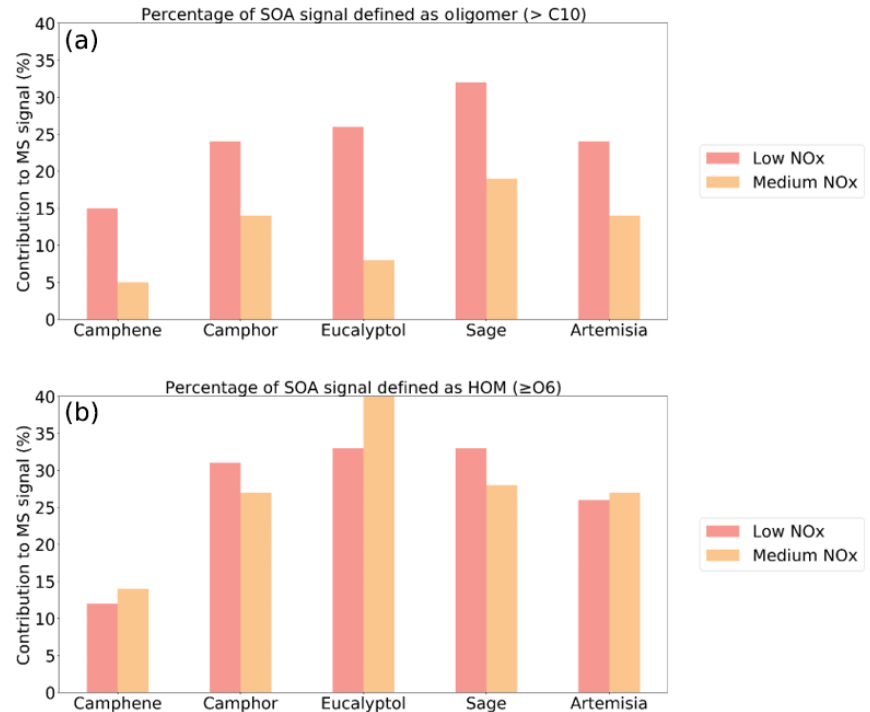
Figure 5. Comparison of the proportion of the signal attributable to oligomeric species (a) and highly oxygenated organic molecules (b)